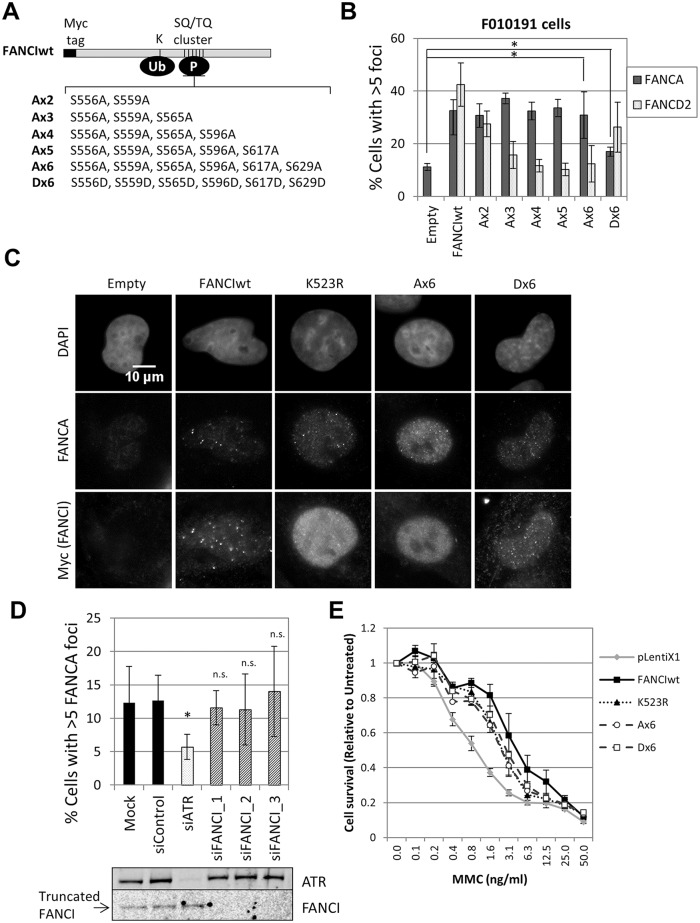
FANCI phosphorylation is not required for FA core complex foci formation.(A) A diagram of FANCI showing important domains and mutant forms analyzed: phosphorylation mutants (Ax2—Ax6) and the phosphomimetic mutant (Dx6). (B) FANCI-deficient F010191 cells were transduced with wild-type and mutant forms of FANCI. Cells were treated with MMC (60 ng/ml) for 24h. The percentage of foci-positive cells is shown (n = 3, mean ± SD). (*) Indicates p < 0.05. (C) Representative images corresponding to the experiment quantified in panel B. (D) FANCI-deficient F010191 cells were transfected with the indicated siRNAs and treated with MMC (60 ng/ml) for 24h. Percentage of foci-positive cells is shown (n = 3, mean ± SD). (*) Indicates p < 0.05; (n.s.) indicates no statistical significance. Protein depletion by siRNA was confirmed by immunoblotting (lower panel). (E) FANCI-deficient F010191 cells were transduced with wild-type and mutant forms of FANCI, plated at low density and treated with increasing concentrations of MMC. The cell-surviving fraction after 7 days, compared to untreated cells is shown (n = 3, mean ± SD).